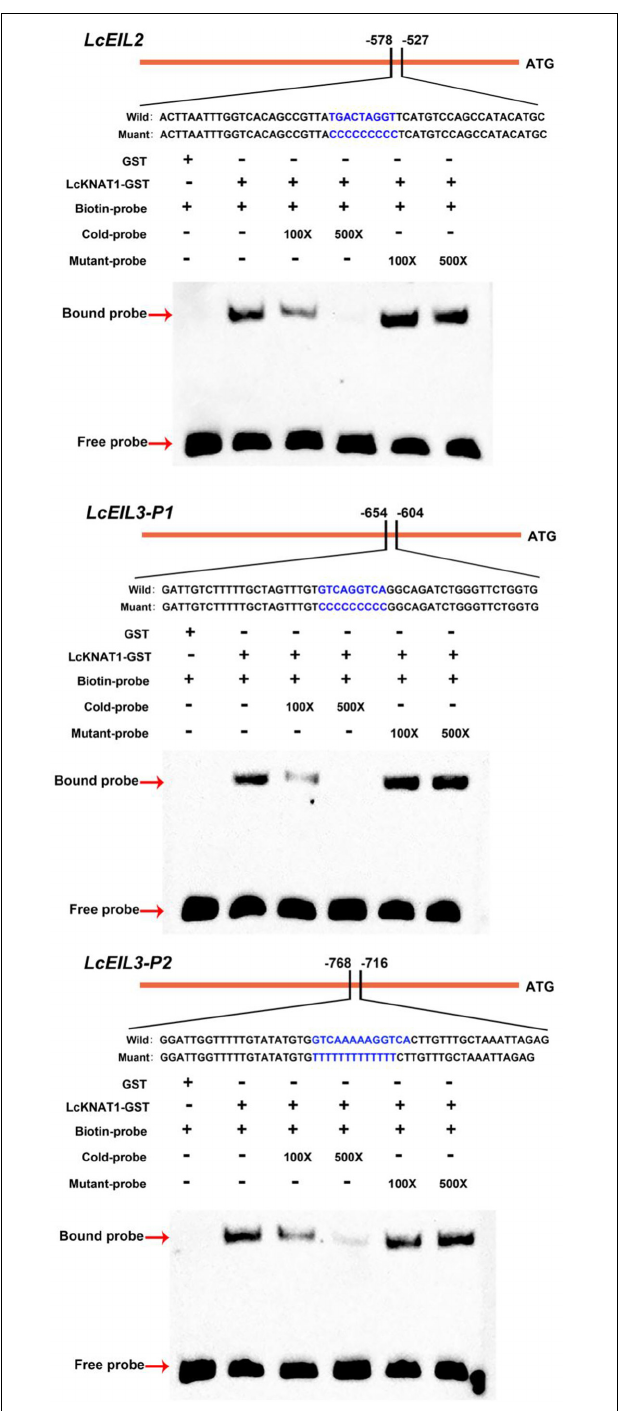
FIGURE 3 | Binding of LcKNAT1 to LcEIL2 and LcEIL3 promoters in vitro . The electrophoretic mobility shift assay (EMSA) using purified LcKNAT1-GST fusion protein. The sequences of wild and mutant probes were shown at the top of the images. Shifted bands, suggesting the formation of DNA-protein complexes, are indicated by arrows. “ – ” represents absence, and “ + ” represents presence. 100 × and 500 × indicate the increasing concentrates of probes. Non-biotin-labeled probe with the same sequence was used as a cold competitor. Only the GST protein was served as a negative